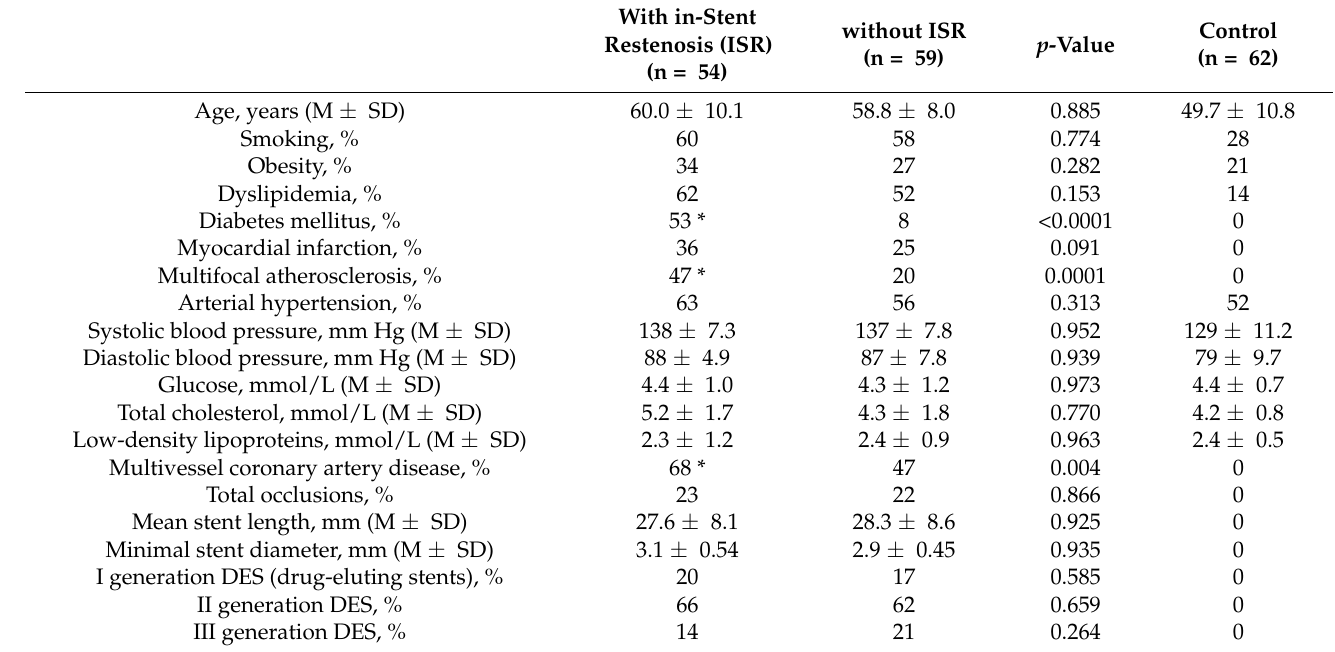
Table 1. General characteristics of studied groups of